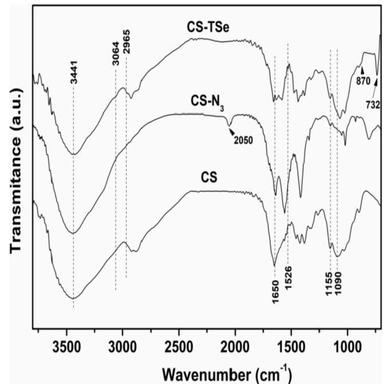
FTIR spectra of CS, CS-N3, and CS-TSe.